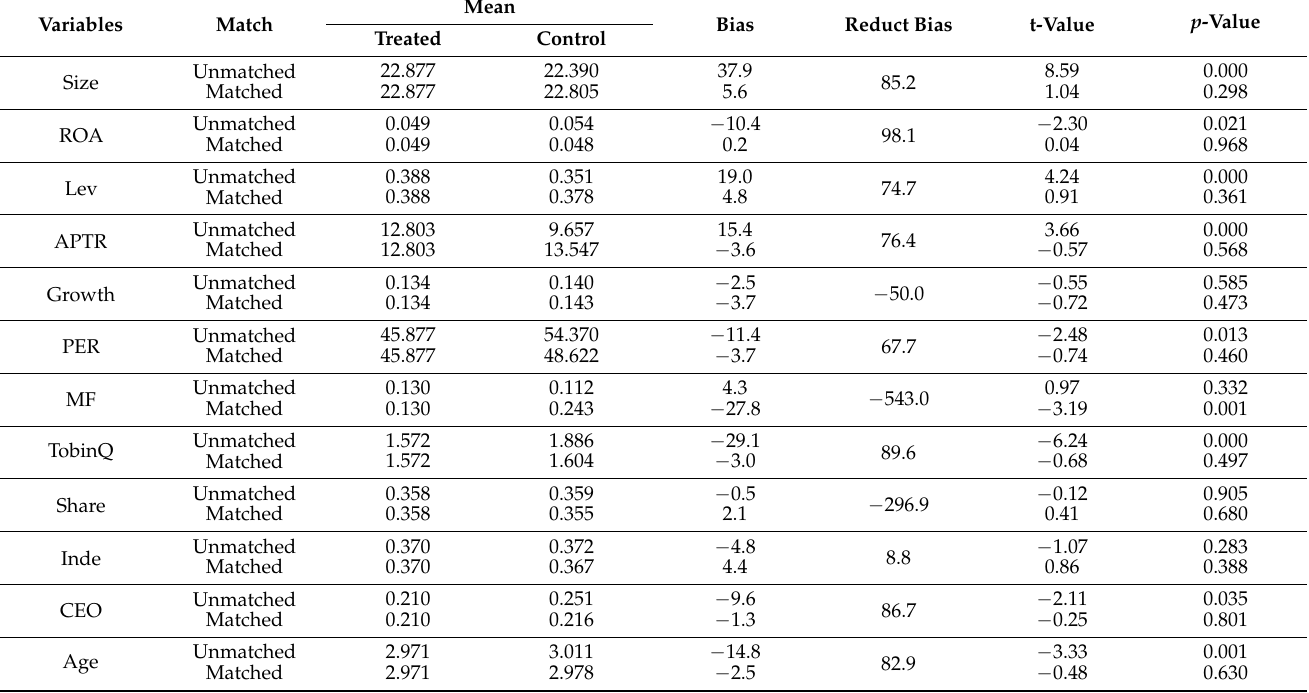
Table A5. Balance hypothesis test: